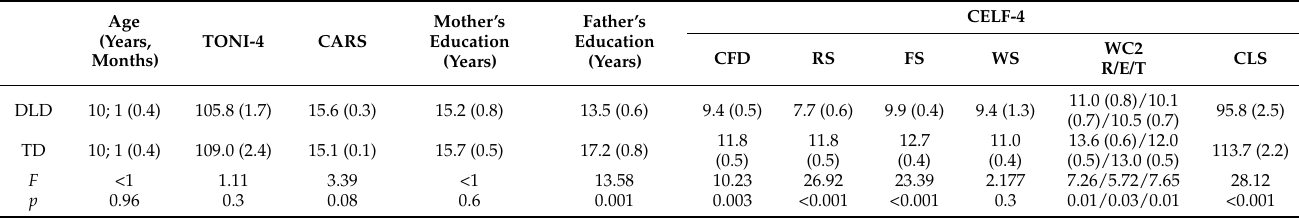
Table 1. Group means for age, nonverbal intelligence (Test of Nonverbal Intelligence—4th edition, TONI-4), presence of autism (Childhood Autism Rating Scale, 2nd edition, CARS-2), socio-economic status (parents’ education level), and linguistic ability (Clinical Evaluation of Language Fundamentals, 4th edition, CELF-4).